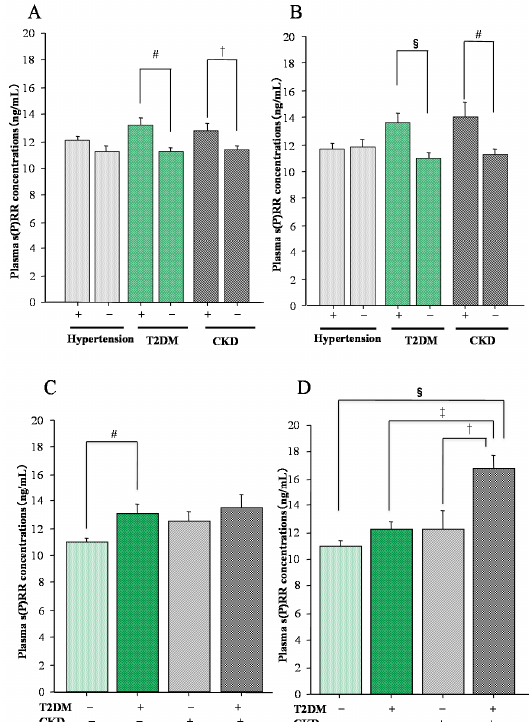
Figure 3. Relation of plasma s(P)RR concentrations with the presence of hypertension, type 2 diabetes mellitus (T2DM), or chronic kidney disease (CKD) in patients with obstructive sleep apnea syndrome (OSAS). ( A ) Male OSAS patients with and without hypertension ( n = 105 and n = 82), with and without T2DM ( n = 41 and n = 146), and with and without CKD ( n = 39 and n = 148); ( B ) Female OSAS patients with and without hypertension ( n = 35 and n = 37), with and without T2DM ( n = 21 and n = 51), and with and without CKD ( n = 13 and n = 59); ( C ) Male OSAS patients without T2DM and CKD ( n = 119), with T2DM but no CKD ( n = 29), with CKD but no T2DM ( n = 27), and with both T2DM and CKD (diabetic kidney disease) ( n = 12); ( D ) Female OSAS patients without T2DM and CKD ( n = 44), with T2DM but no CKD ( n = 15), with CKD but no T2DM ( n = 8), and with both T2DM and CKD (diabetic kidney disease) ( n = 5). Data are shown as means ± S.D. († p < 0.05; ‡ p < 0.01; # p < 0.005; § p < 0.001). Reproduced from Reference [23] with kind permission from the Tohoku University Medical Press, Sendai, Japan.